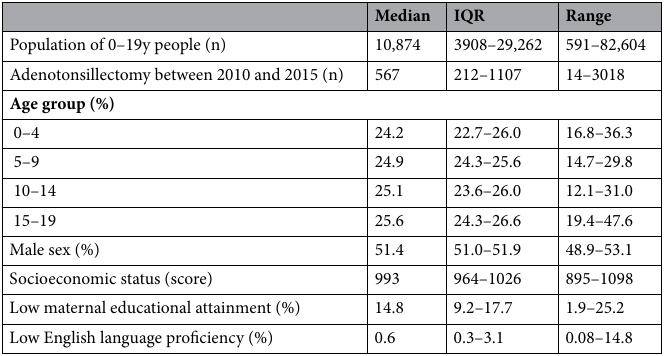
Table 1. Summary statistics of socio-demographic variables at the Local Government Area level. Population of 0-19y people was calculated for each Local Government Area by averaging the area’s population over five years (2010–2015). IQR interquartile